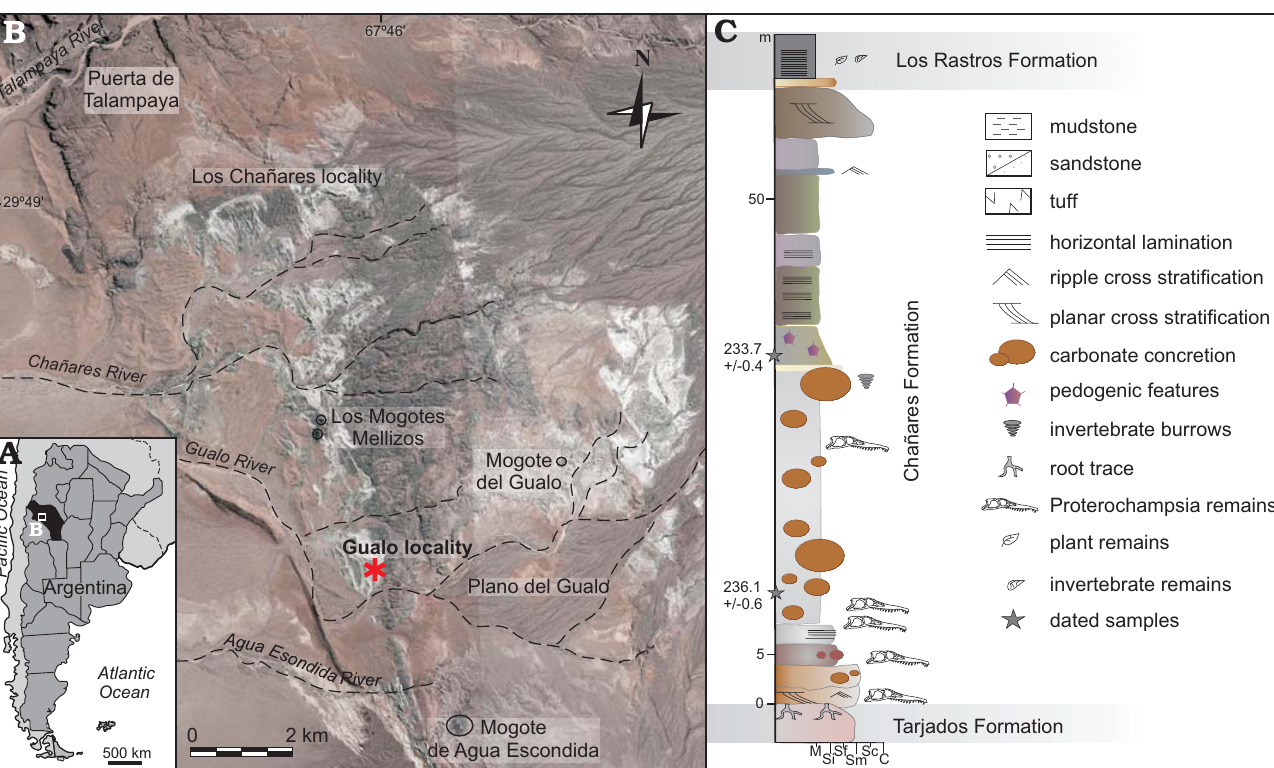
Fig. 2. A . Geographic location of the Río Chañares-Río Gualo area in the La Rioja Province (in black), Argentina. B . Map showing location of the studied area in the Talampaya National Park; Gualo locality asterisked. C . Stratigraphic section of the Chañares Formation at the Gualo locality with the samples locations. Abbreviations: M, mudstone; Si, silstone; Sf, fine-grained sandstone; Sm, medium-grained sandstone; Sc, coarse-grained sandstone; C, con-